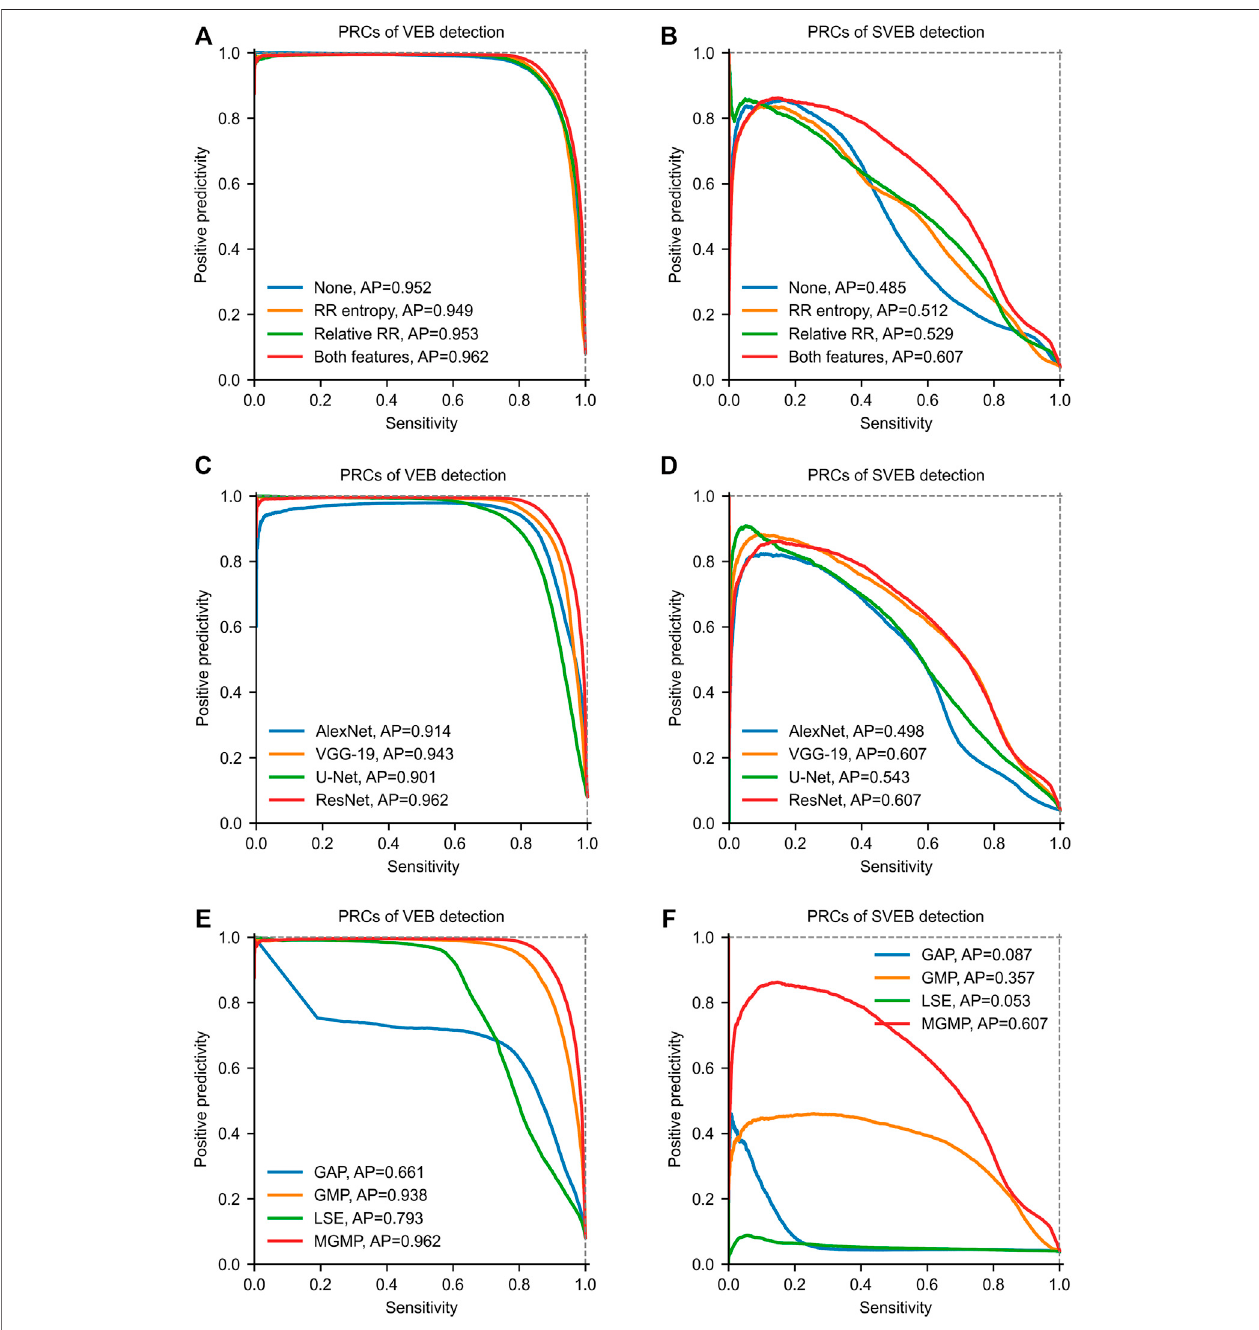
FIGURE7| Precision-recallcurves(PRCs)oftheablationstudiesonthetotaltestdata. (A) and (B) showPRCsofmodelswithdifferentknowledge-basedfeatures. (C) and (D) show PRCs of models with different feature extraction networks. (E) and (F) show PRCs of models with different aggregation mechanisms. GAP = global average pooling. GMP = global max pooling. LSE = Log-Sum-Exp. MGMP = masked global max pooling. AP = average precision. The parameter b of LSE is set to 5.